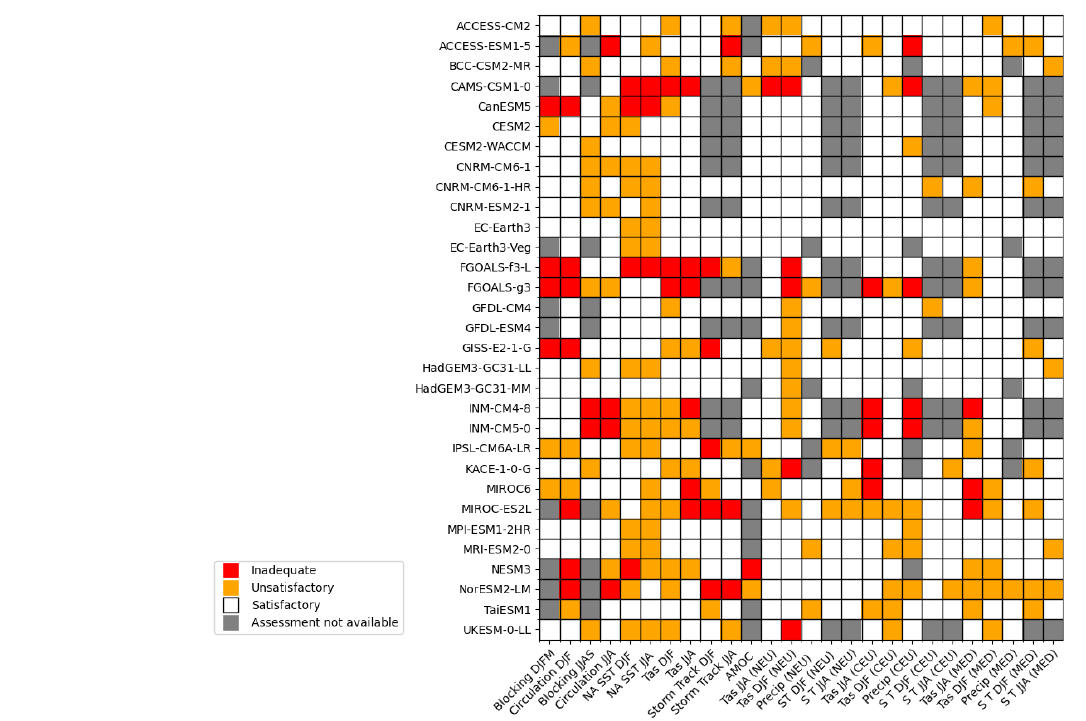
Figure 5. Model assessment summary for qualitative European criteria. Assessment criteria for the large scale are as follows: blocking – blocking frequency; circulation – large-scale circulation assessed by 850hPa wind speed and direction; NA SST – NA SST bias; Tas – surface air temperature bias at 2m; storm track – based on RMSE of the zonal mean track 20 ◦ W–20 ◦ E; and AMOC – based on strength at 1000m at 26 ◦ N. Assessment criteria for the European regions are as follows: Tas – surface air temperature bias at 2m; Precip – annual precipitation cycle; and ST – storm track assessed as cyclones per season within the European region.